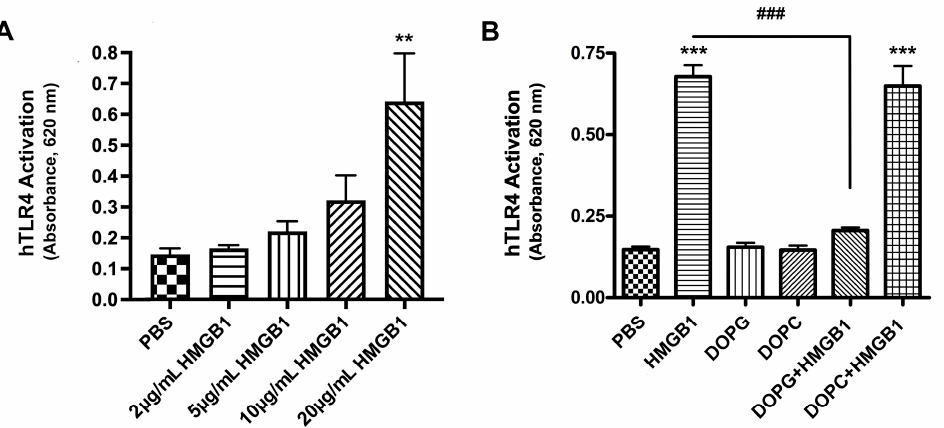
Figure 5. HMGB1-induced activation of TLR4 was inhibited by DOPG but not DOPC. SEAP was measured as absorbance at 620 nm to indicate hTLR4 activity. Experiments were performed on three separate occasions, with results representing the mean ± standard error of the mean of the absorbance. ( A ) HEK-Blue-hTLR4 cells were incubated for 24 h with phosphate buffered saline (PBS, control) or recombinant HMGB1 at the indicated concentrations. hTLR4 activation by HMGB1 was dose dependent. ** p < 0.01 versus control (PBS). ( B ) HEK-Blue-hTLR4 cells were incubated with or without 15 µg/mL HMGB1 in the presence or absence of 10 µg/mL DOPG or DOPC. DOPG, but not DOPC, inhibited the activation of hTLR4 by HMGB1. *** p < 0.001 versus control (PBS); ### p < 0.001 as indicated, using ANOVA with Tukey’s post-hoc testing. hTLR4, human toll-like receptor 4; HMGB1, high mobility group box 1; PBS, phosphate-buffered saline; DOPG, dioleoylphosphatidylglycerol; DOPC,